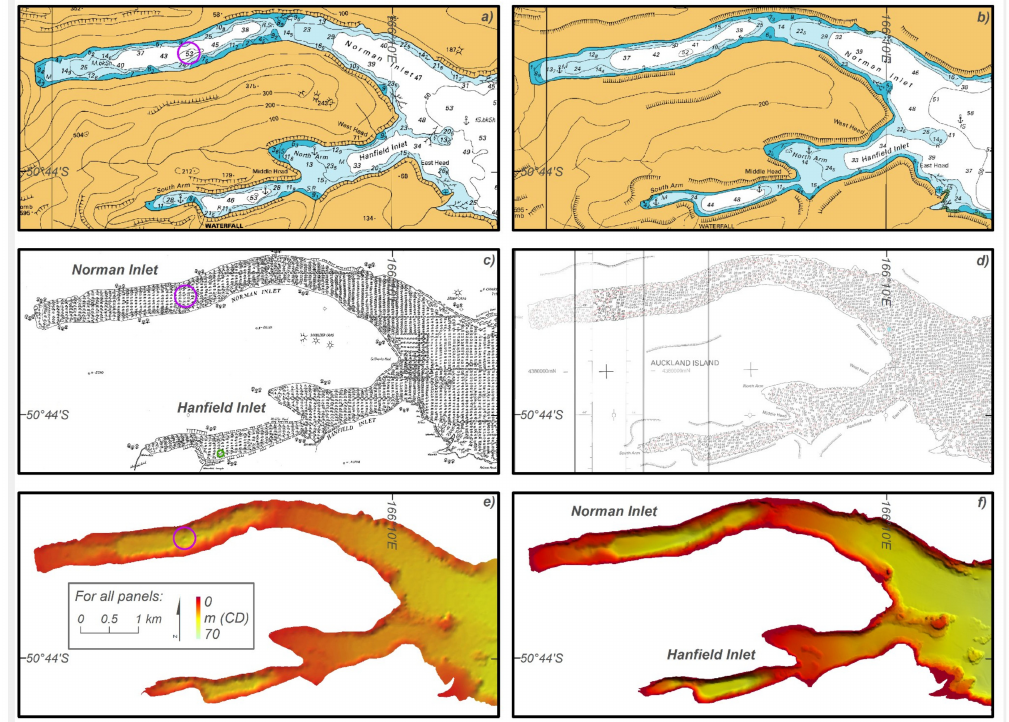
Figure 3. Norman and Hanfield Inlet study area: ( a ) Chart NZ2862 2005 edition, location of the isolated low discussed in the text is circled in purple; ( b ) Chart NZ2862 2017 edition; ( c) pre-2015 fairsheet2862-25, “R” symbol discussed in the text is circled in green; ( d ) post-2015 Standard sheets HS42-STD-06&07; ( e ) Bathymetric surface created from ( c ), prominent seabed features discussed in the text are circled in blue; ( f ) Bathymetric surface from .csar file with 0 values interpolated to coastline contour in ( d